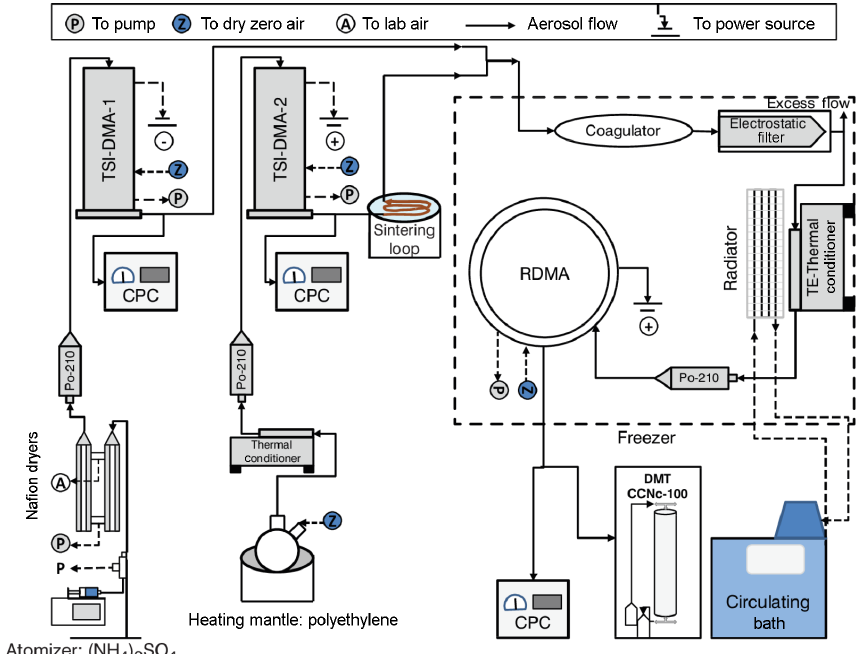
Figure 1. Schematic of the experimental setup (DMA: differential mobility analyzer, RDMA: radial differential mobility analyzer, CPC: con- densation particle counter, DMT CCNc-100: cloud condensation nuclei counter, Po-210: Polonium 210 radiation